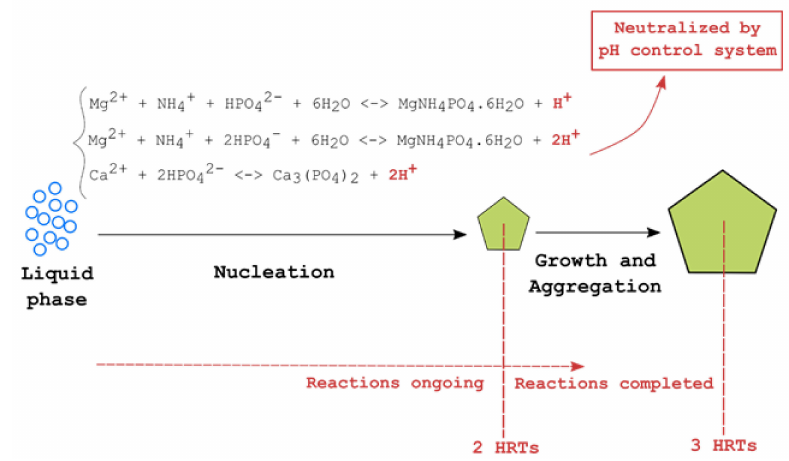
Figure 2. Mechanism of nucleation, growth and aggregation of crystals. Table 2. Summary of experiments